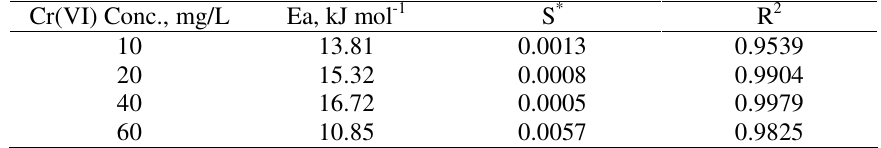
Figure 4. Plot of ln(1- θ ) vs. reciprocal temperature for the adsorption of Cr(VI) onto FMPGP. Table 4 . Sticking probability and activation energy for the adsorption of Cr(VI) onto